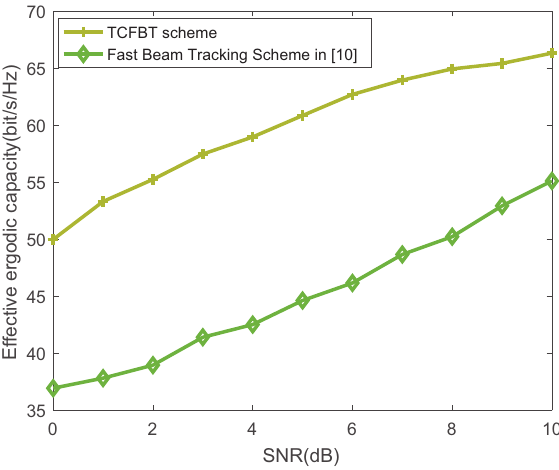
Figure 11. The effective ergodic capacity vs.